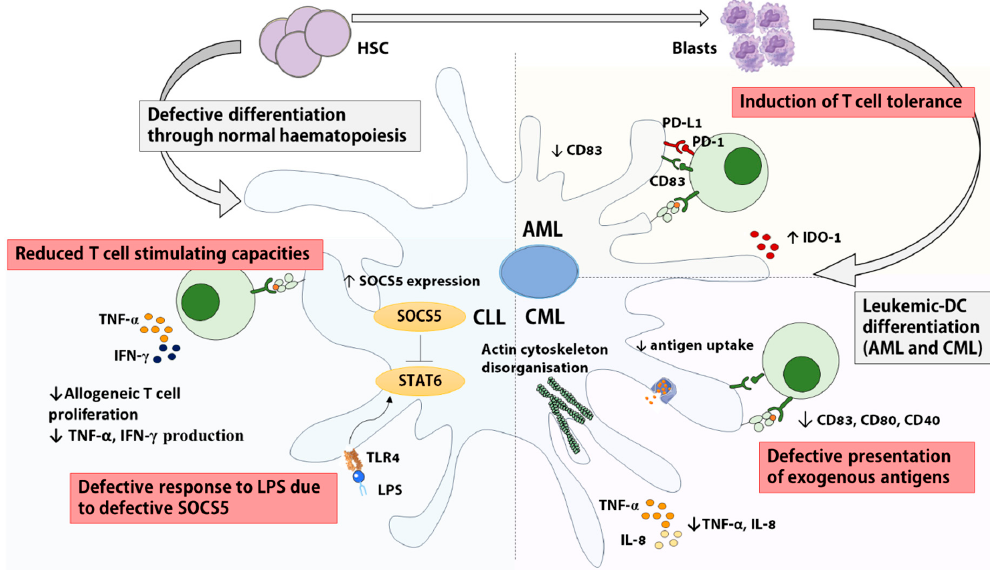
Figure 2. Impairments to conventional and monocyte-derived dendritic cell function in